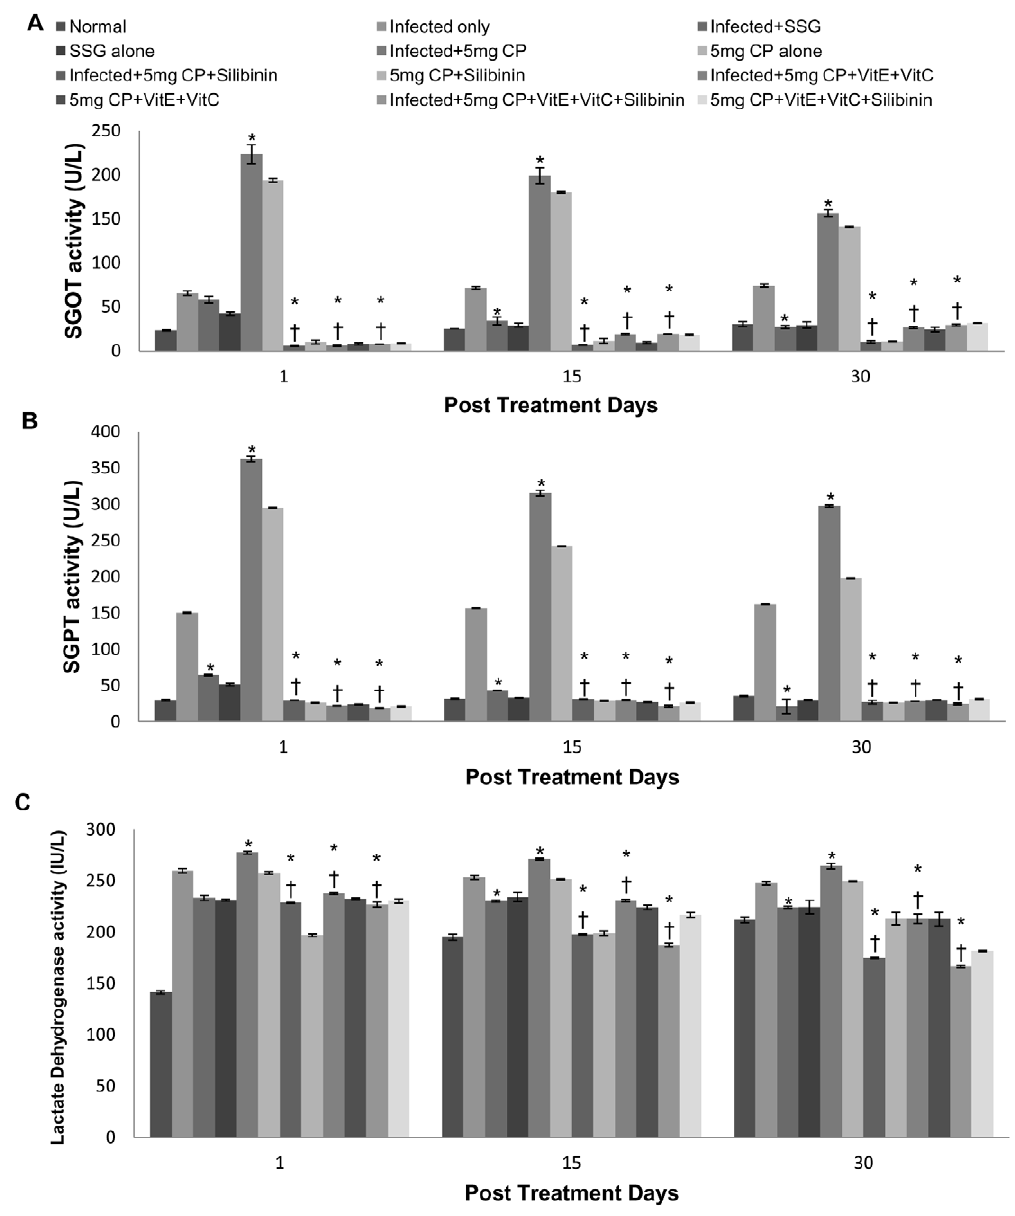
Figure 7. SGOT, SGPT and LDH activity in serum samples of different groups of animals. A- SGOT, B-SGPT, C-LDH. The data are presented as mean 6 S.D. of six mice per group.* -p value: Infected only vs Infected + SSG/Infected + 5 mg CP/Infected + 5 mg CP + Silibinin/Infected + 5 mg CP + VitE + VitC/Infected + 5 mg CP + VitE + VitC + Silibinin. { -p value: Infected + 5 mg CP vs. Infected + 5 mg CP + Silibinin/Infected + 5 mg CP + VitE + VitC/ Infected + 5 mg CP + VitE + VitC + Silibinin. *, { -p ,